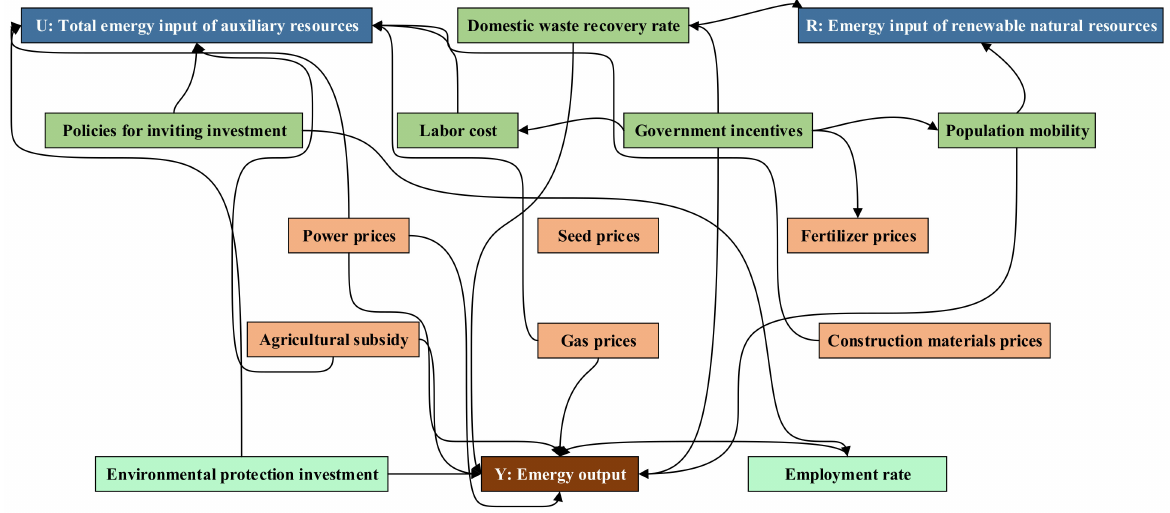
Figure 6. System dynamics causal relationship diagram of the rural human settlement